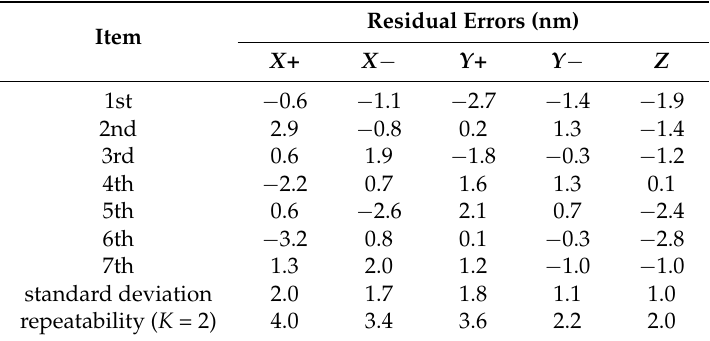
Table 2. Results of the trigger test.